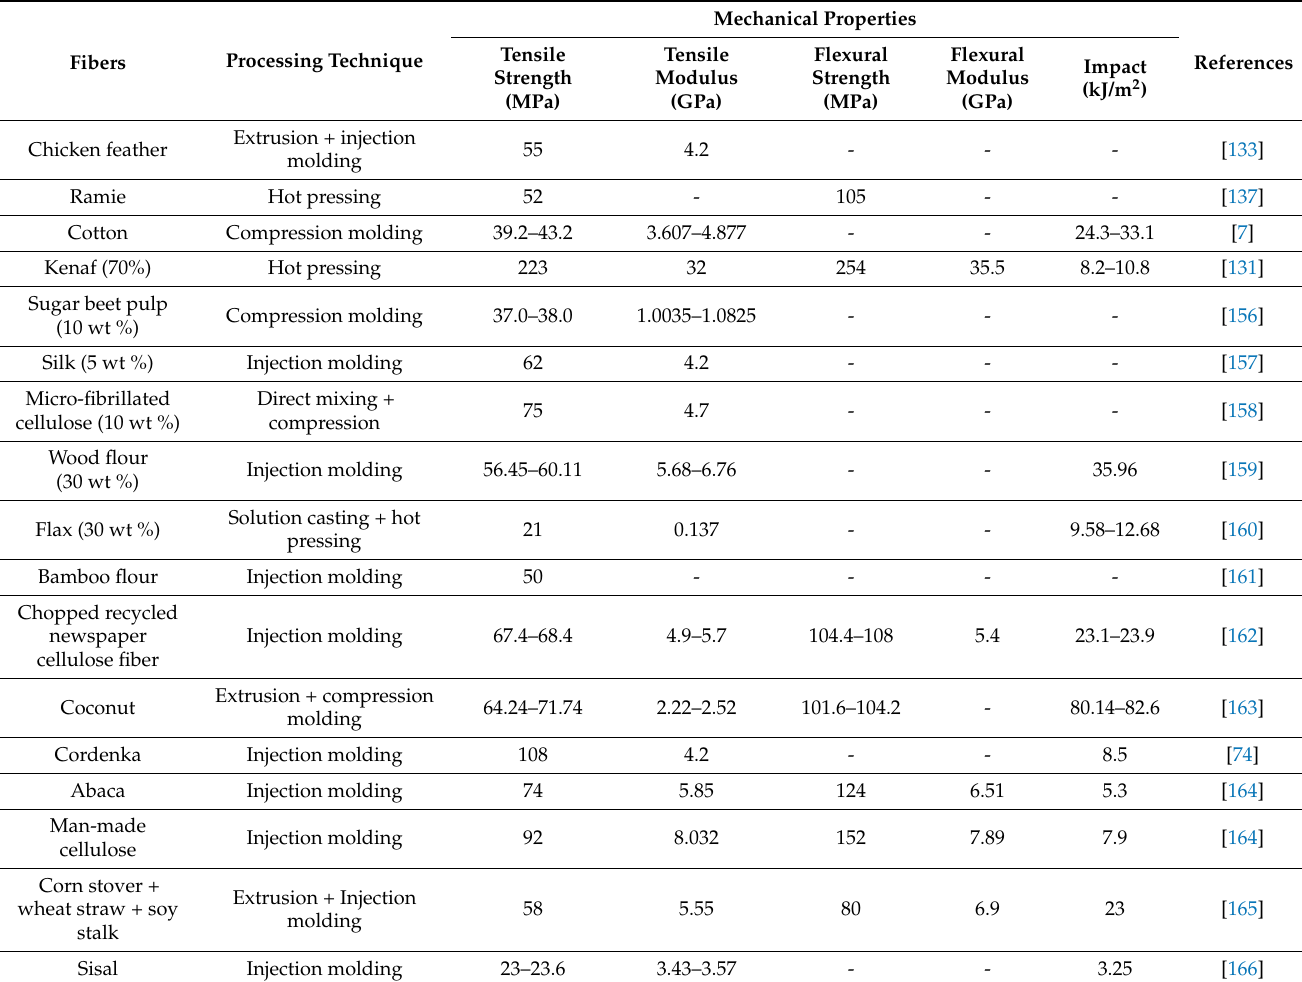
Table 7. Mechanical properties of PLA-reinforced natural